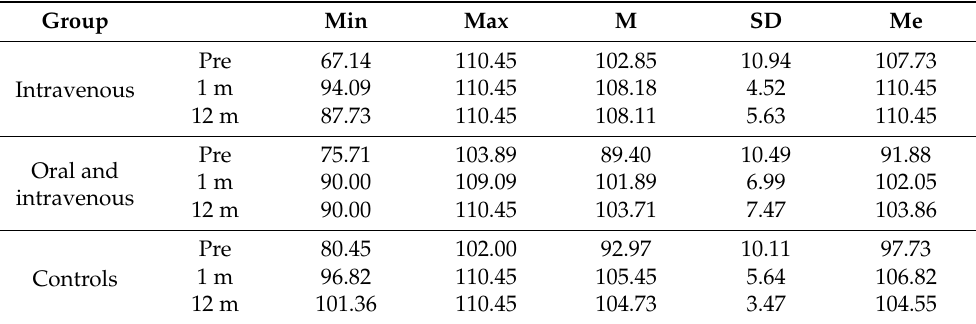
Table 3. Hearing thresholds of patients at each of the three study